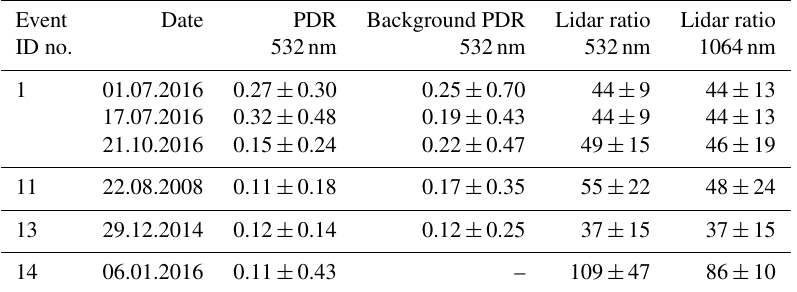
Table 6. Mean plume values for lidar-specific aerosol properties (PDR – particulate depolarization ratio; lidar ratio) and uncertainty estimates based on CALIPSO